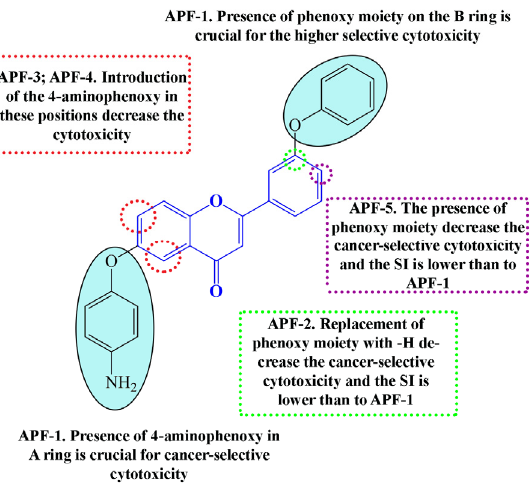
Figure 2. Effect of the 4-aminophenoxy moiety and phenoxy moiety position on the selective cytotoxicity of the compounds against non-small lung cancer (NSCLC) cells.